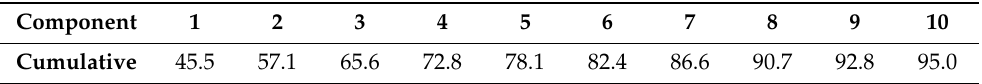
Table 2. Principal component analysis: cumulative proportion of total variation (%) calculated from correlation matrix by